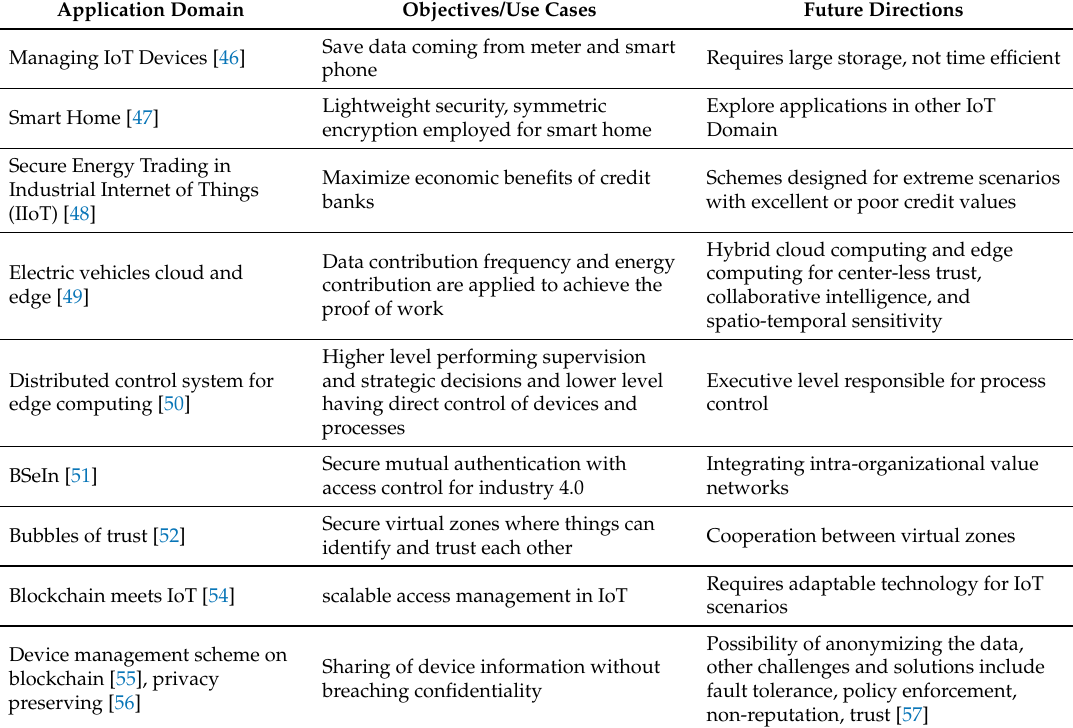
Table 3. Use cases, design challenges, and future directions in industrial control